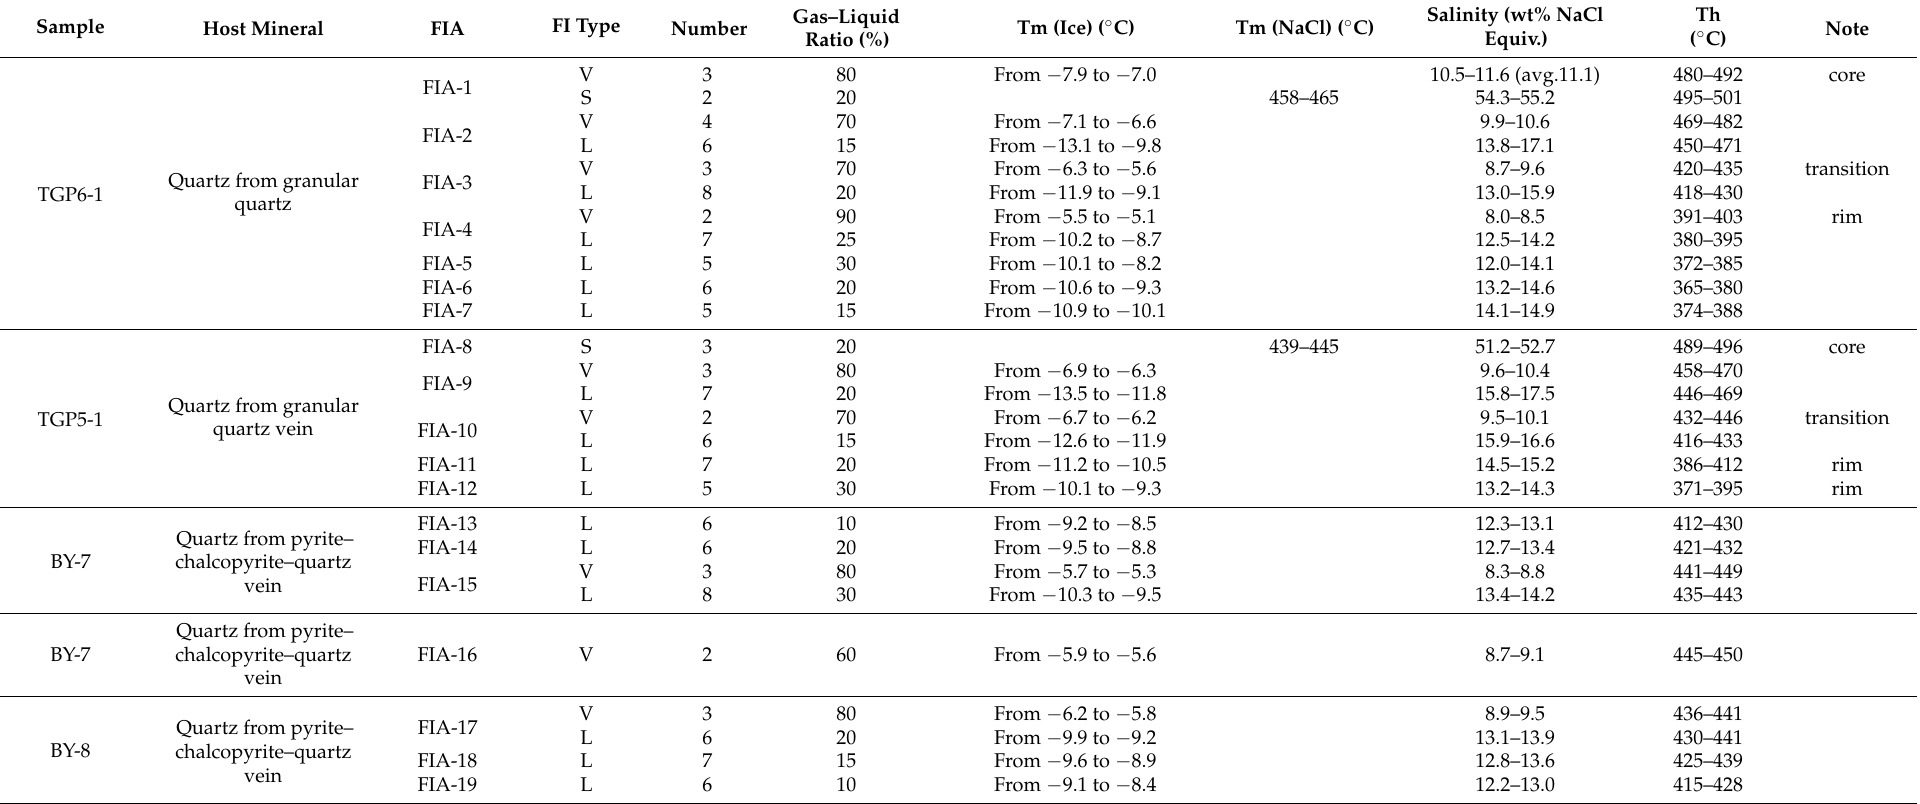
Table 1. Microthermometric data from FIAs in quartz from porphyry Cu mineralization of the Tonggou